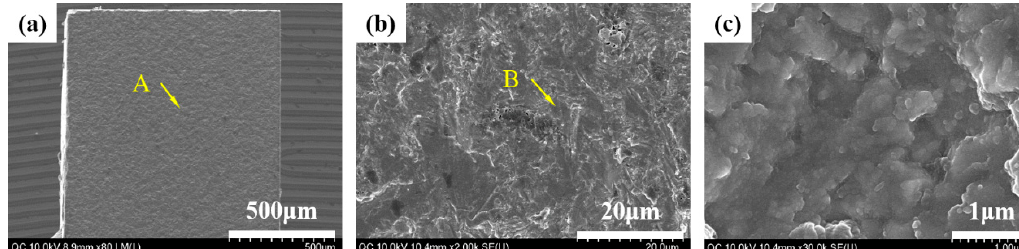
Figure 7. HR FE-SEM images of the cement-bonded group demonstrating mode of failure with the microtensile bond strength test. ( a ) Fractured surface of specimen demonstrating the homogeneous pattern of fracture, ( b ) the magnification of point A demonstrating the irregular structure of the zirconia ceramic, and ( c ) the magnification of point B demonstrating the crystal structure of zirconia. The null hypothesis was rejected on the initial chipping and fracture strengths but accepted on the fracture strength. The mean values and standard deviations of the initial chipping strength and fracture strength of implant-supported glass ceramic crowns bonded to zirconia ceramic abutments were 843.8 ± 317.5 N and 1929.6 ± 191.1 N for the liner-bonded (MLG) groups and 341.0 ± 90.2 N and 1711.1 ± 275.4 N for the resin cement-bonded (MGC) group (Figure 8). The initial chipping strength